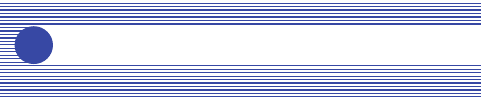
63 cm Figure 2: Illustration showing the measurement system of the GBPP-100, representing a laser beam intercepted by a raindrop (illustration not to